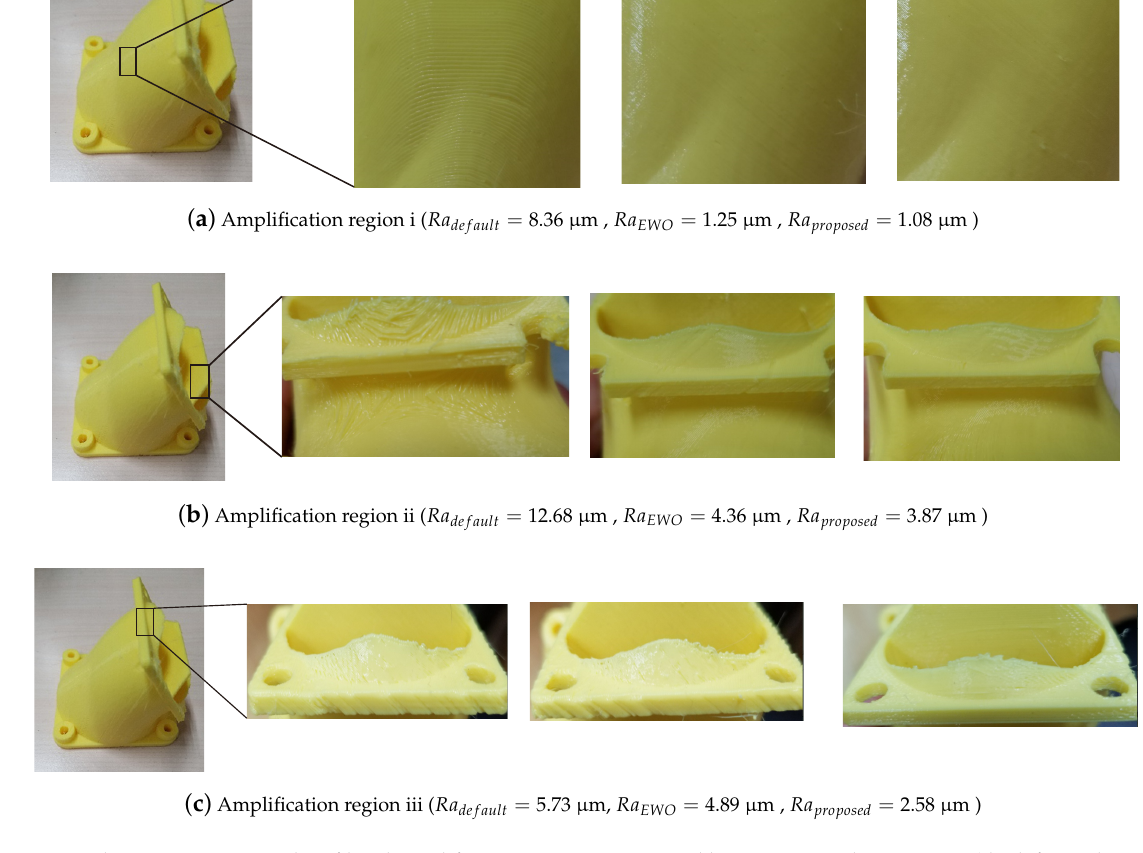
Figure 14. The comparison results of local amplification regions measured by TR200 roughness meter (the left, medium and right figure in turn are the orientation determined by default, EWO and method proposed,